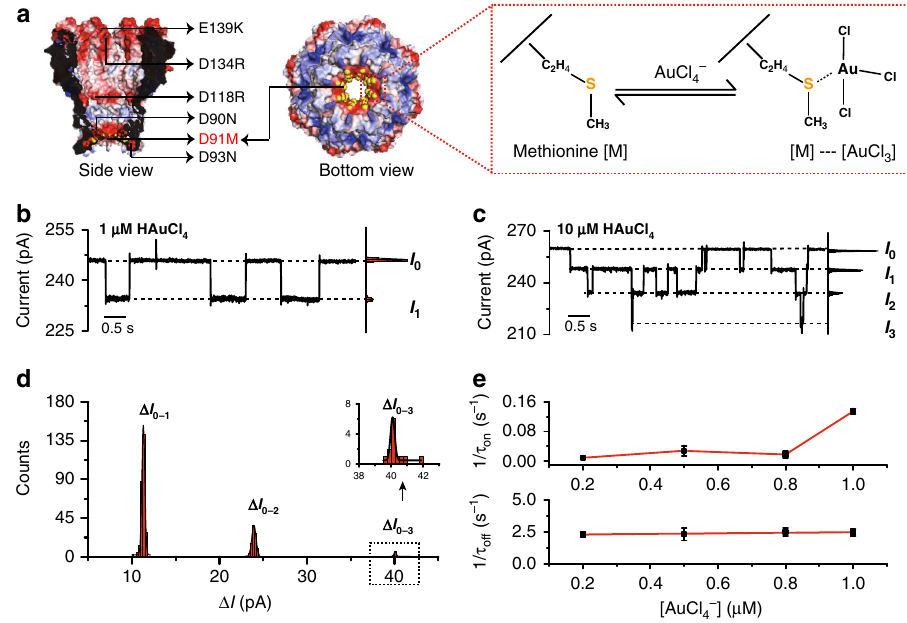
Fig. 1 Binding of [AuCl 4 ] − with methionine (D91M) within an engineered MspA nanopore (MspA-M). a The structure of MspA (PDB ID: 1uun 32 ) and its sensing mechanism with [AuCl 4 ] − ions. Pore engineering (D93N/D91M/D90N/D118R/D134R/E139K) was performed according to published methods with the exception of D91M for [AuCl 4 ] − sensing. The mutant MspA (MspA-M) possesses eight identical methionine residues at position 91, and capable of binding multiple [AuCl 4 ] − ions simultaneously. b, c Representative traces with all-points histogram for [AuCl 4 ] − sensing by MspA-M at + 100 mV with 1 μ M and 10 μ M HAuCl 4 in cis , respectively. With 1 μ M HAuCl 4 in cis ( b ), most binding events are from single [AuCl 4 ] − ions. Though rarely observed, it is possible to observe events resulted from simultaneous binding of two [AuCl 4 ] − in the same pore, which accounts for ~3% of all the events acquired. However, with 10 μ M HAuCl 4 in cis ( c ), sequential binding events from multiple [AuCl 4 ] − dominate. I n stands for n [AuCl 4 ] − ions simultaneously in the pore. d Event histogram for 5 min recording for [AuCl 4 ] − binding by MspA-M with 10 μ M HAuCl 4 in cis . Gaussian fi tting is performed for binding events from different numbers of [AuCl 4 ] − . Δ I 0 − 1 : 11.3 ± 0.2 pA, N = 280; Δ I 0 − 2 : 24.0 ± 0.3 pA, N = 94; Δ I 0 − 3 : 40.1 ± 0.2 pA, N = 13 ( Δ I 0 − 1 stands for the current difference between I 0 and I 1 ; Δ I 0 − 2 stands for the current difference between I 0 and I 2 ; Δ I 0 − 3 stands for the current difference between I 0 and I 3 ). e Plot of the reciprocals of the mean inter-event intervals ( τ on ) and plot of the reciprocals of the mean residence time ( τ off ) for single [AuCl 4 ] − binding events